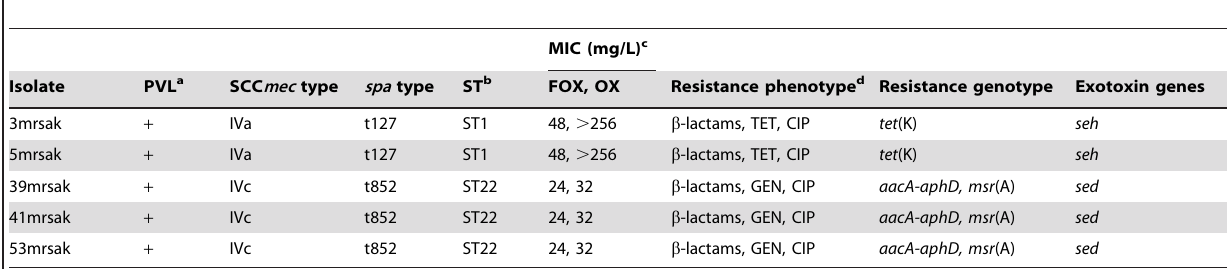
Table 2. Characteristics of Methicillin-resistant Staphylococcus aureus (MRSA) isolated from rooks.